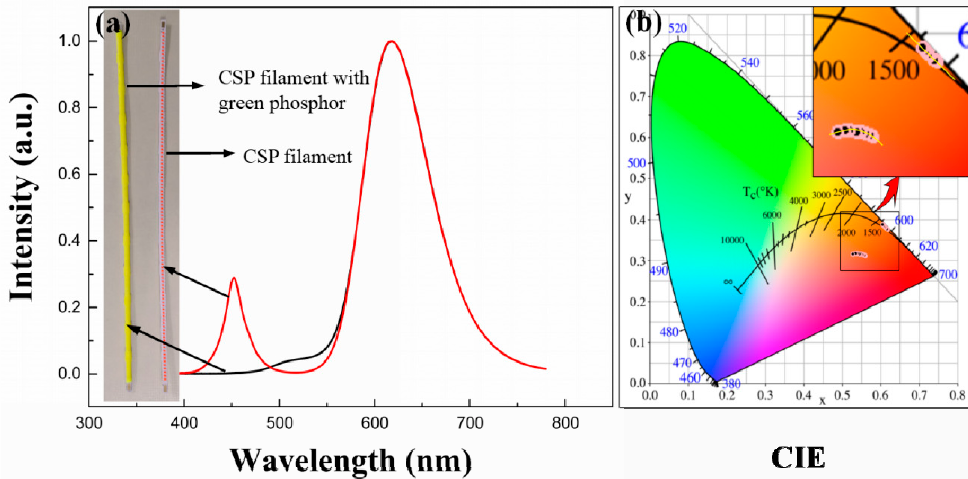
Figure 2. ( a ) Electro luminescence (EL) spectra of pure red CSP filament before and after package; ( b ) the Commission Internationale de L’Eclairage (CIE)-1931 chromaticity coordinates of pure red CSP filament before and after package.